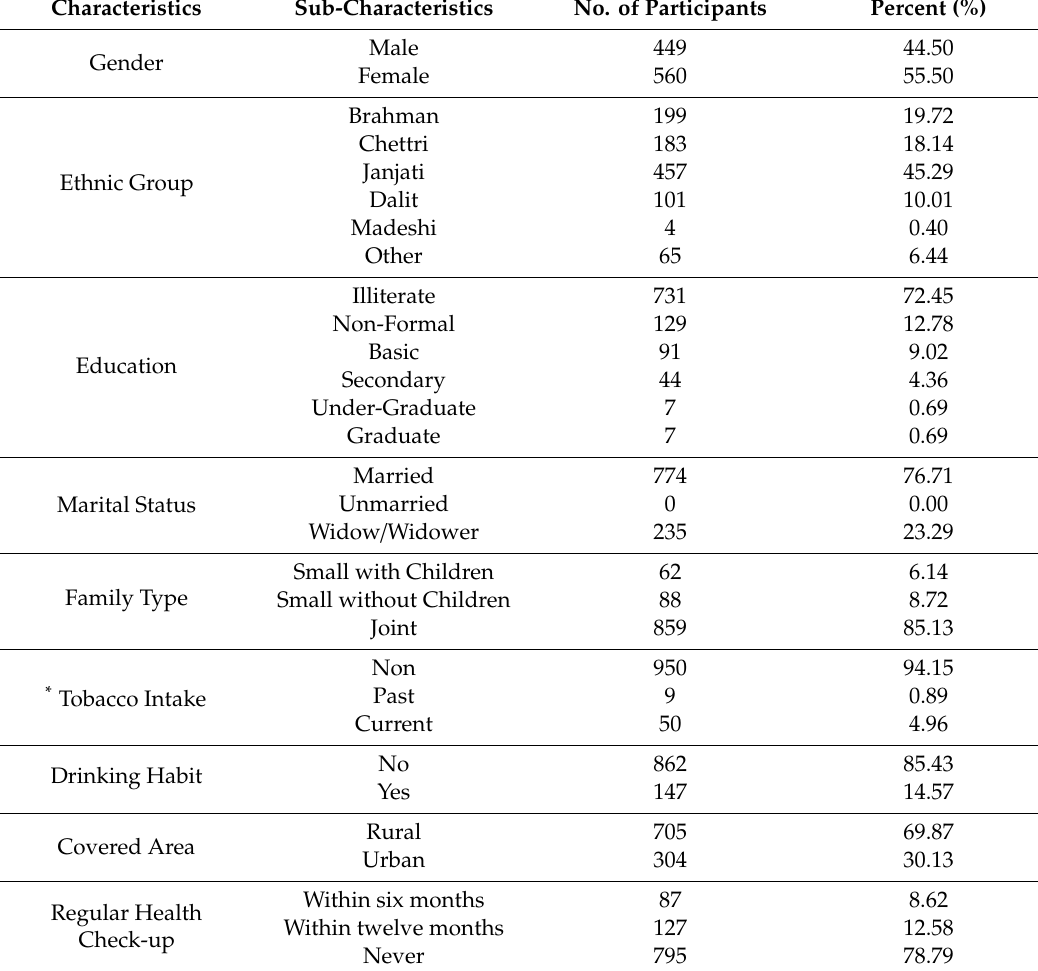
Table 1. General characteristics of the